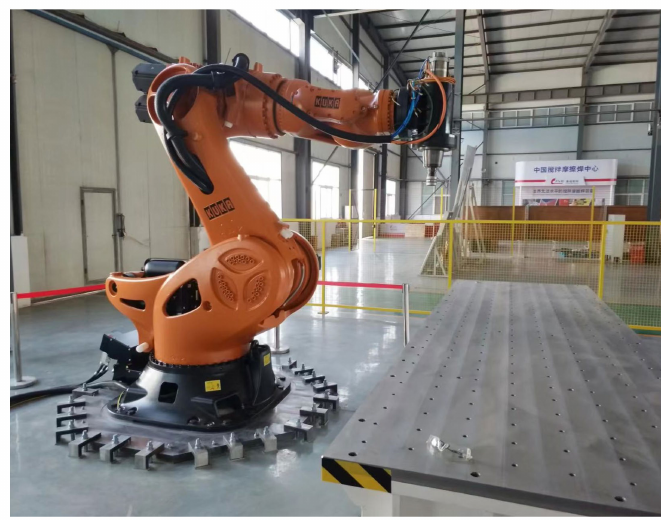
Figure 1. KUKA Titan industrial robot.